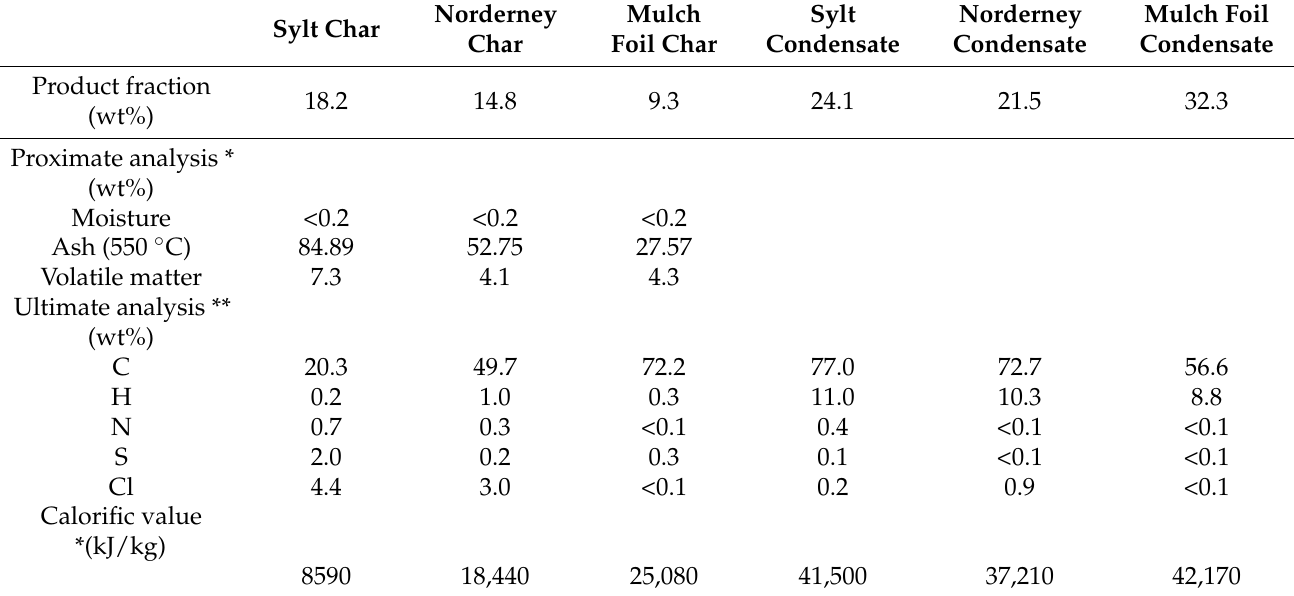
Table 6. Characteristics of pyrolysis products derived from different plastic wastes (as received) (* n = 2; ** n = 3). Norderney Mulch Sylt Norderney Mulch Foil Sylt Char Char Foil Char Condensate Condensate